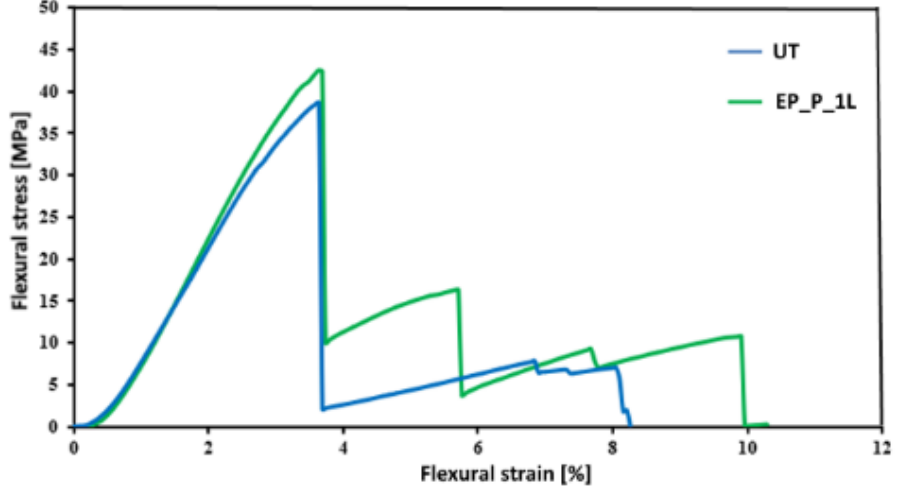
Figure 10. Typical stress-strain flexural curves of UT and EP_P_1L sandwich structures. Table 6. Comparison between treated and untreated sandwich structures .